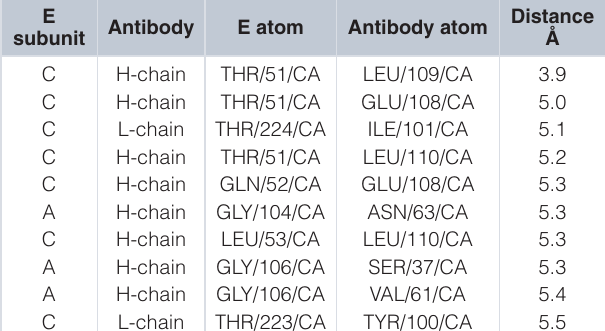
Table 3. Interacting residues of the potent DENV antibody 5J7 (PDB ID:3J6U) with other subunits, sorted based on distance. Thr51 in the DENV-3 protein (chain C) is closest to the Leu109 of the heavy chain (H-chain), and Thr223/Thr224 in the DENV-3 protein (chain C) is closest to Ile101 in the light chain (L-chain). Thr224 is conserved in ZIKV and the other DENV serotypes. However, Thr51 is conserved only in DENV1, while Thr223 is not conserved in ZIKV or other DENV serotypes, explaining the lack of neutralization of other serotypes by 5J7. The H-chain also binds to the conserved fusion loop of another DENV3-E protein (chain